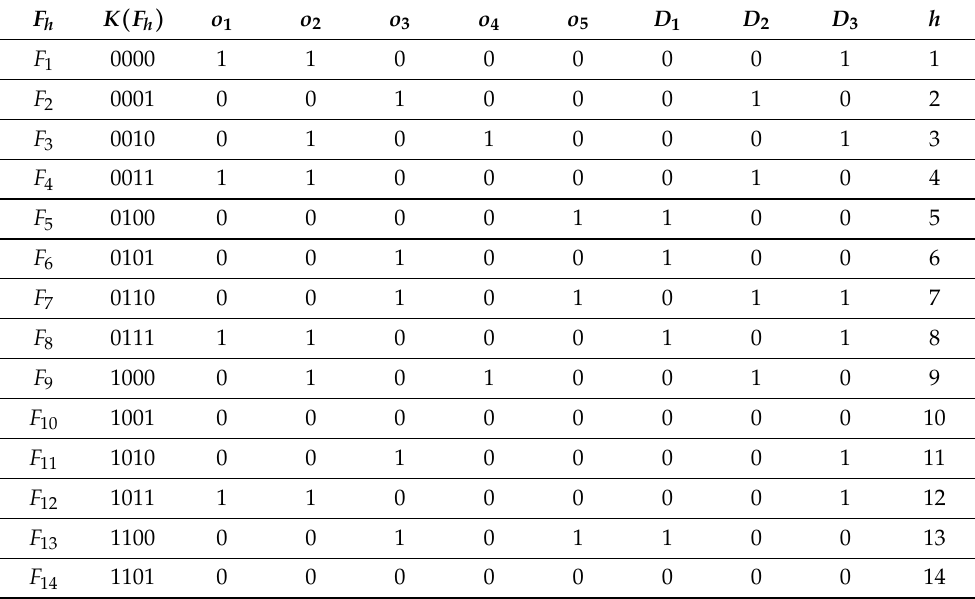
Table 8. Contents of programmable read-only memories (PROMs) of PH Mealy FSM A 2